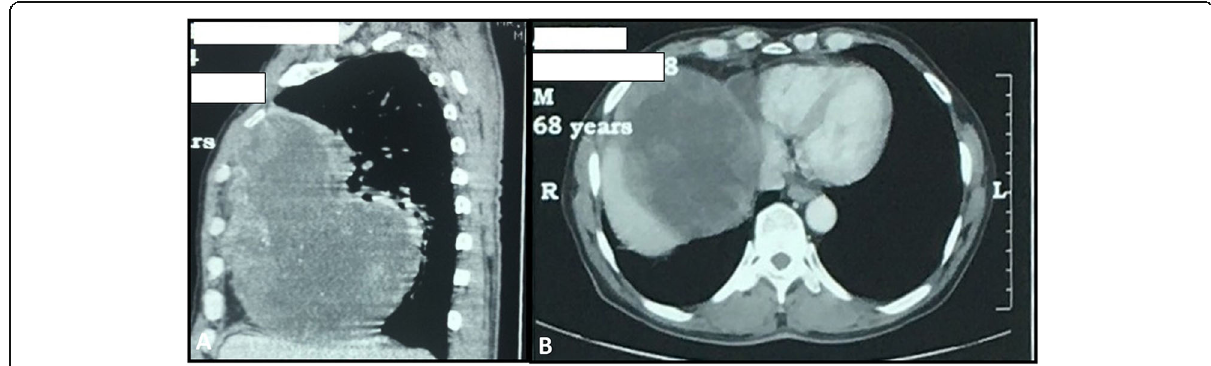
Fig. 1 Contrast enhanced CT scan of chest shows a large anterior mediastinal soft tissue mass with loss of fat planes, abutting diaphragm and extending to the right hemithorax with inhomogeneous areas of necrosis. ( A Sagittal view & B Mediastinal